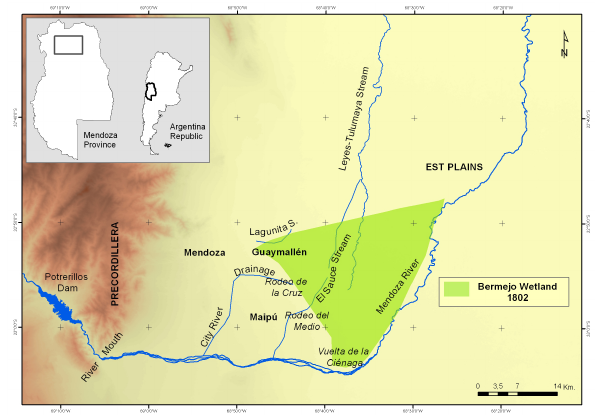
Fig. 1. Study area. The viewer can see the River of the City, the Drainage Channel (Desag¨ue) and the Lagunita Stream. At the East of the City there was the Great Bermejo Swamp (grey shadow) as it looked in